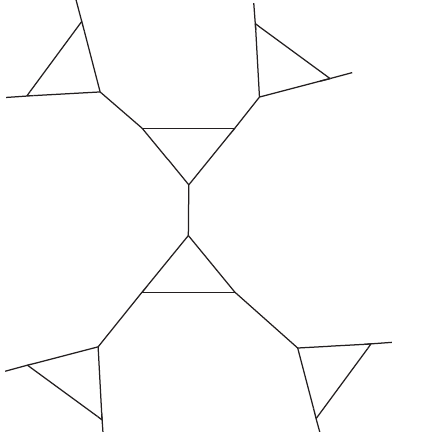
Figure 2: An overview of the small portion of infinite